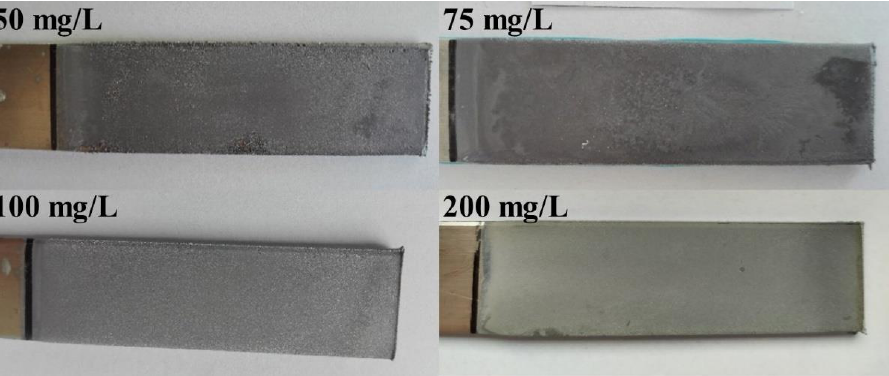
Figure 5. Photos of electrodeposited lead at different concentrations of bone glue as an inhibitor.